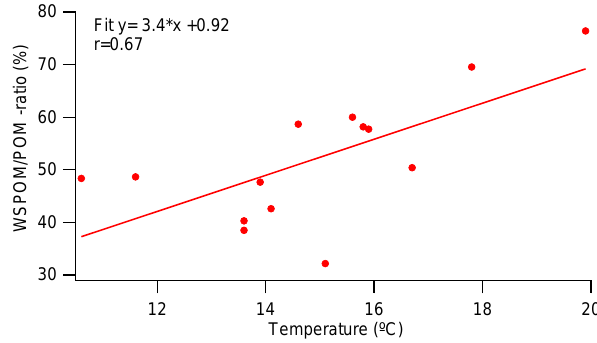
Fig. 7. Average WSPOM/POM-ratios in afternoon (12:00 to 16:00) vs. daily maximum temperature between 25 April, and 8 May